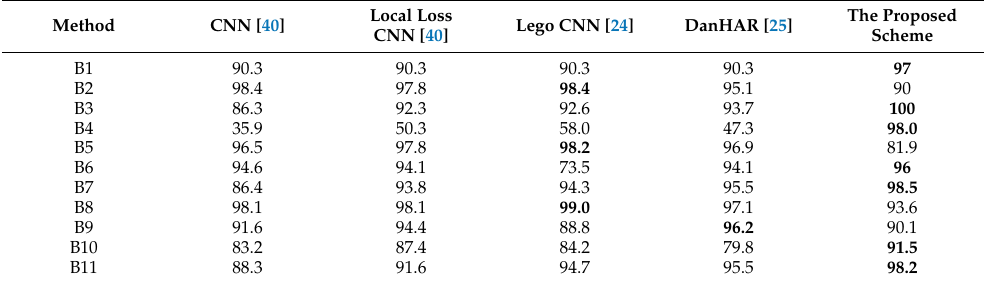
Table 8. The comparison of recall of 11 types of activities using different schemes in PAMAP2 data